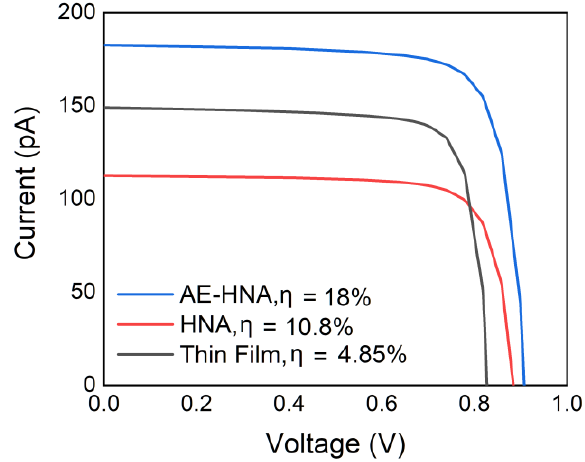
Figure 7. The current–voltage characteristics of the AE-HNA, HNA, and thin-film structures.